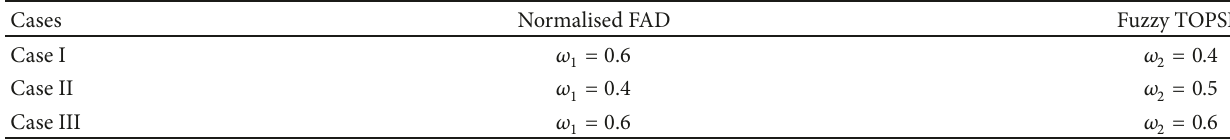
Table 22: Weights for the solution methods.